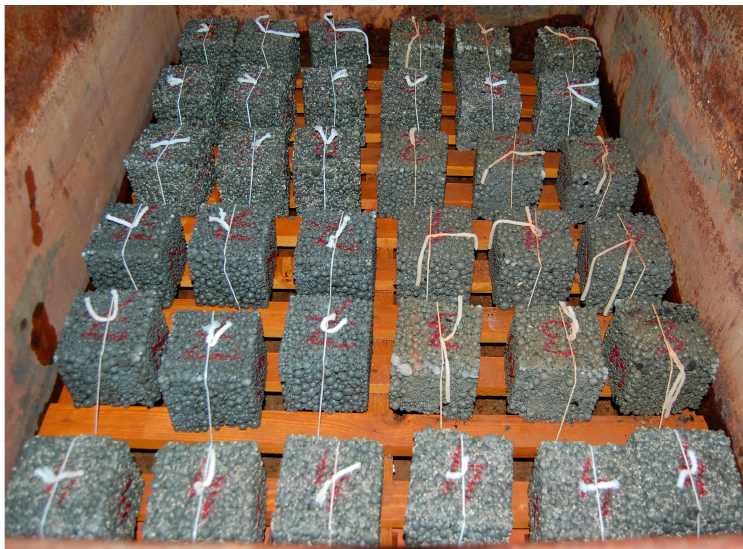
Figure 1. Test specimens in a bath in a refrigeration chamber before soaking.